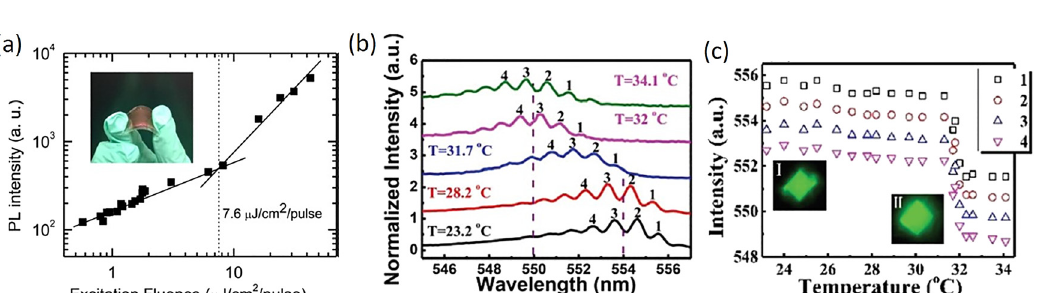
Figure 18: (a) Schematic of the device stack. (b) The transmission spectrum of the CLC reflector on glass (left axis) with PL spectrum from the perovskite thin-film overlaid (black circles, right axis). The blue line shows the modeled transmission spectrumof thedevice stackusingthe4 × 4 Berreman matrix approach. (c) SEM cross- sectional image of the full device structure on the glass. The alumina layer has been shaded for contrast. (d) Emission from full device stack (red), stack without CLC (black), and stack without CLC and alumina (blue dashed), with pulsed excitation